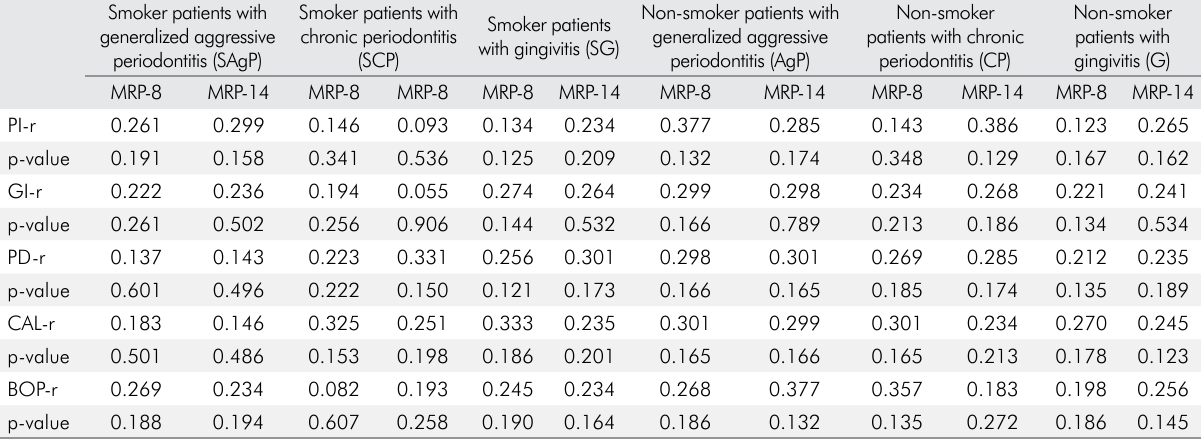
Table 3. Correlations Between MRP-8, MRP-14 Levels, and Clinical Periodontal Measurements of Study Groups (Spearman’s rank correlation